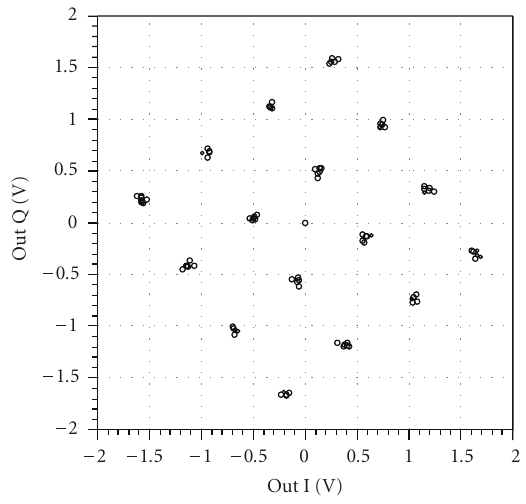
Figure 16: Constellation of demodulated 16 QAM signal in the case of 45 Æ phase error of synchronism.